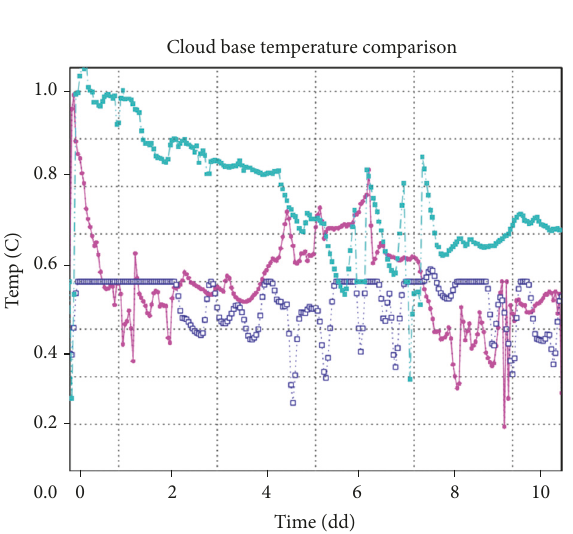
Figure 2: Plot of cloud base temperature for the three case studies. Case Study 3 is dominated by lower cloud bases and hence higher cloud base temperatures. Blue: Case Study 1; purple: Case Study 2; green: Case Study